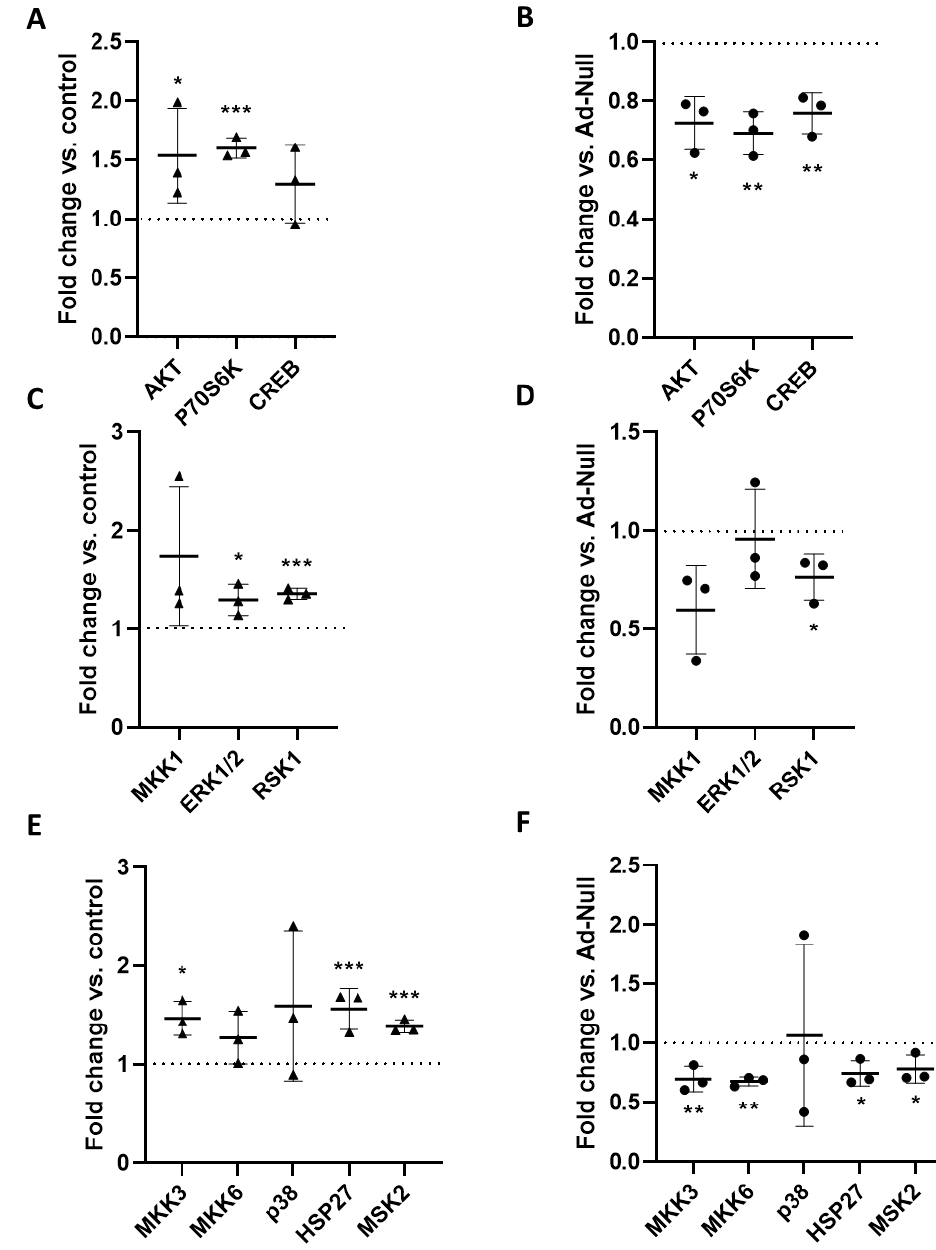
Figure 4. Analysis of kinase phosphorylation in aoSMC spheroids. Ad-Null- ( A , C , E ) or Ad-Rgs5 ( B , D , F )-transduced murine aoSMC spheroids were stimulated for 15 min with either solvent (control) or ET-1 (100 nM). Protein lysates of the spheroids were subjected to a (phosphor)kinase protein array that detects the level of phosphorylation at the following (activating) phosphorylation sites of selected kinases: Akt (P-Ser473), P70S6K (P-Thr421/Ser424), CREB (P-Ser133), MKK1 (P-Ser217/Ser221), ERK1 (P-T202/Y204)/ERK2 (P-Y185/Y187), RSK1 (P-Ser380), MKK3 (P-Ser189), MKK6 (P-Ser207), p38 (P-Thr180/Tyr182), HSP27 (P-Ser82), and MSK2 (P-Ser360). The phosphorylation level was assessed densitometrically ( A , B : AKT-related signaling pathway with P70S6K and CREB as AKT targets; C , D : MAP kinase kinase 1 (MKK1) → ERK1/2 → RSK1 signaling pathway; E , F : MAP kinase kinase 3/6 (MKK3/6) → p38 → HSP27/MSK2 signaling pathway, n = 3, * p < 0.05, ** p < 0.01, *** p < 0.001 vs. control or Ad-Null (dotted line, set to 1)). A representative array is shown as Figure